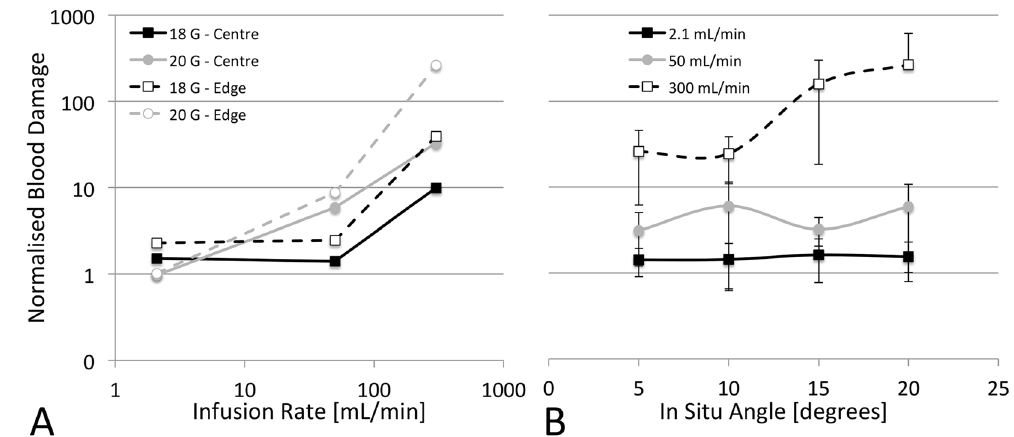
Figure 4. Effects of catheter infusion rate ( A ) and in situ angle ( B ) on blood damage. Blood damage is normalized to that of the patent vein and is presented on a log scale. Infusion rate also shown on log scale in ( A ).